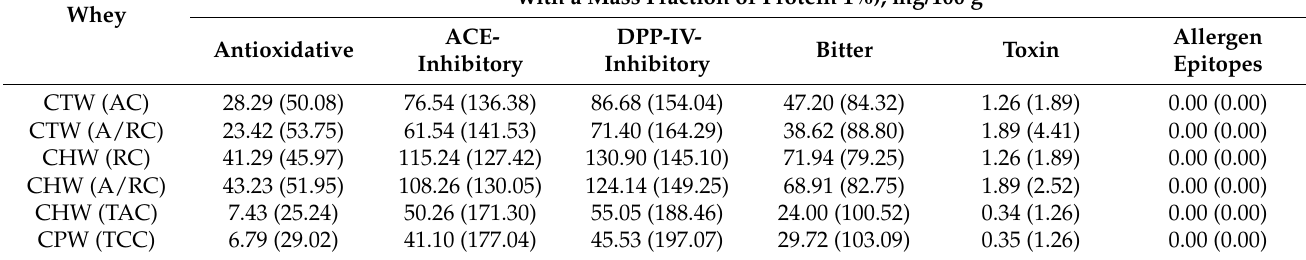
Table 6. Potential concentration of bioactive peptides in hydrolysates of different types of whey. Content of Bioactive Peptides in Hydrolysates of Different Types of Whey (in Terms of Standardized Whey with a Mass Fraction of Protein 1%), mg/100 Whey